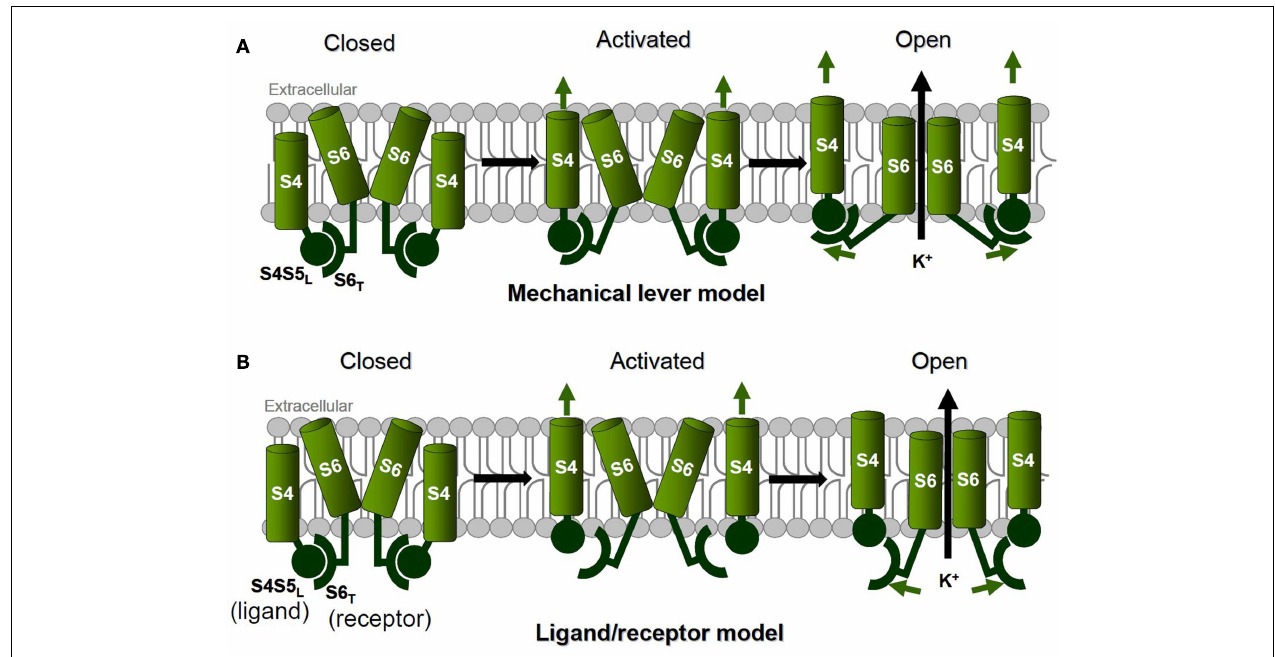
and Shaker. (B) The ligand/receptor model with a loose and state-dependent coupling between voltage sensor movement and pore opening, as suggested for KCNQ1